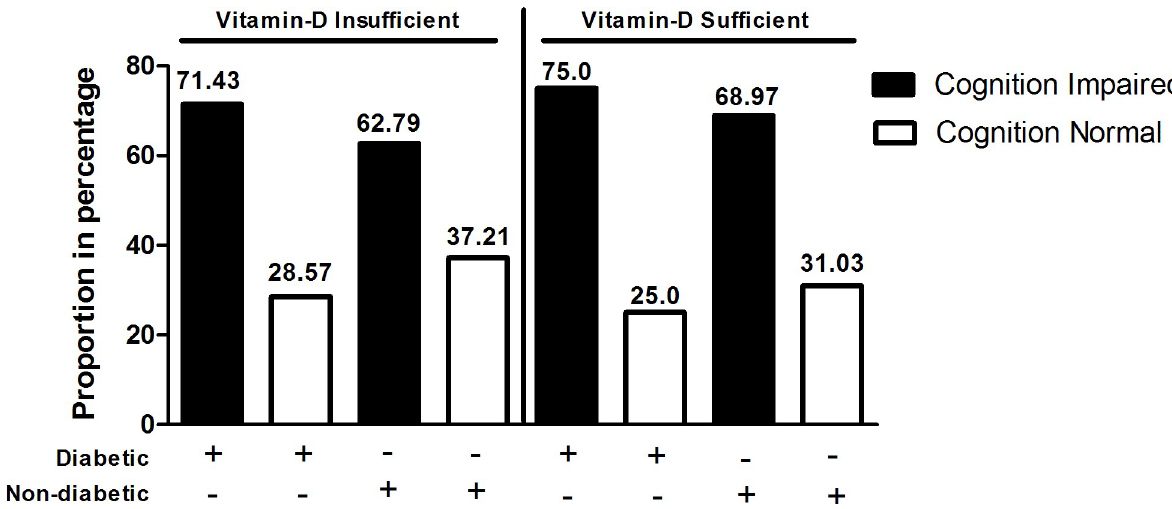
Fig 2. Percentage proportion of subjects in each group represents diabetic (71.43%) and non-diabetic (62.79%) subjects having vitamin-D insufficiency with cognition impairment whereas diabetic (75%) and non-diabetic (68.97%) were vitamin-D sufficient subjects with cognition impairment.